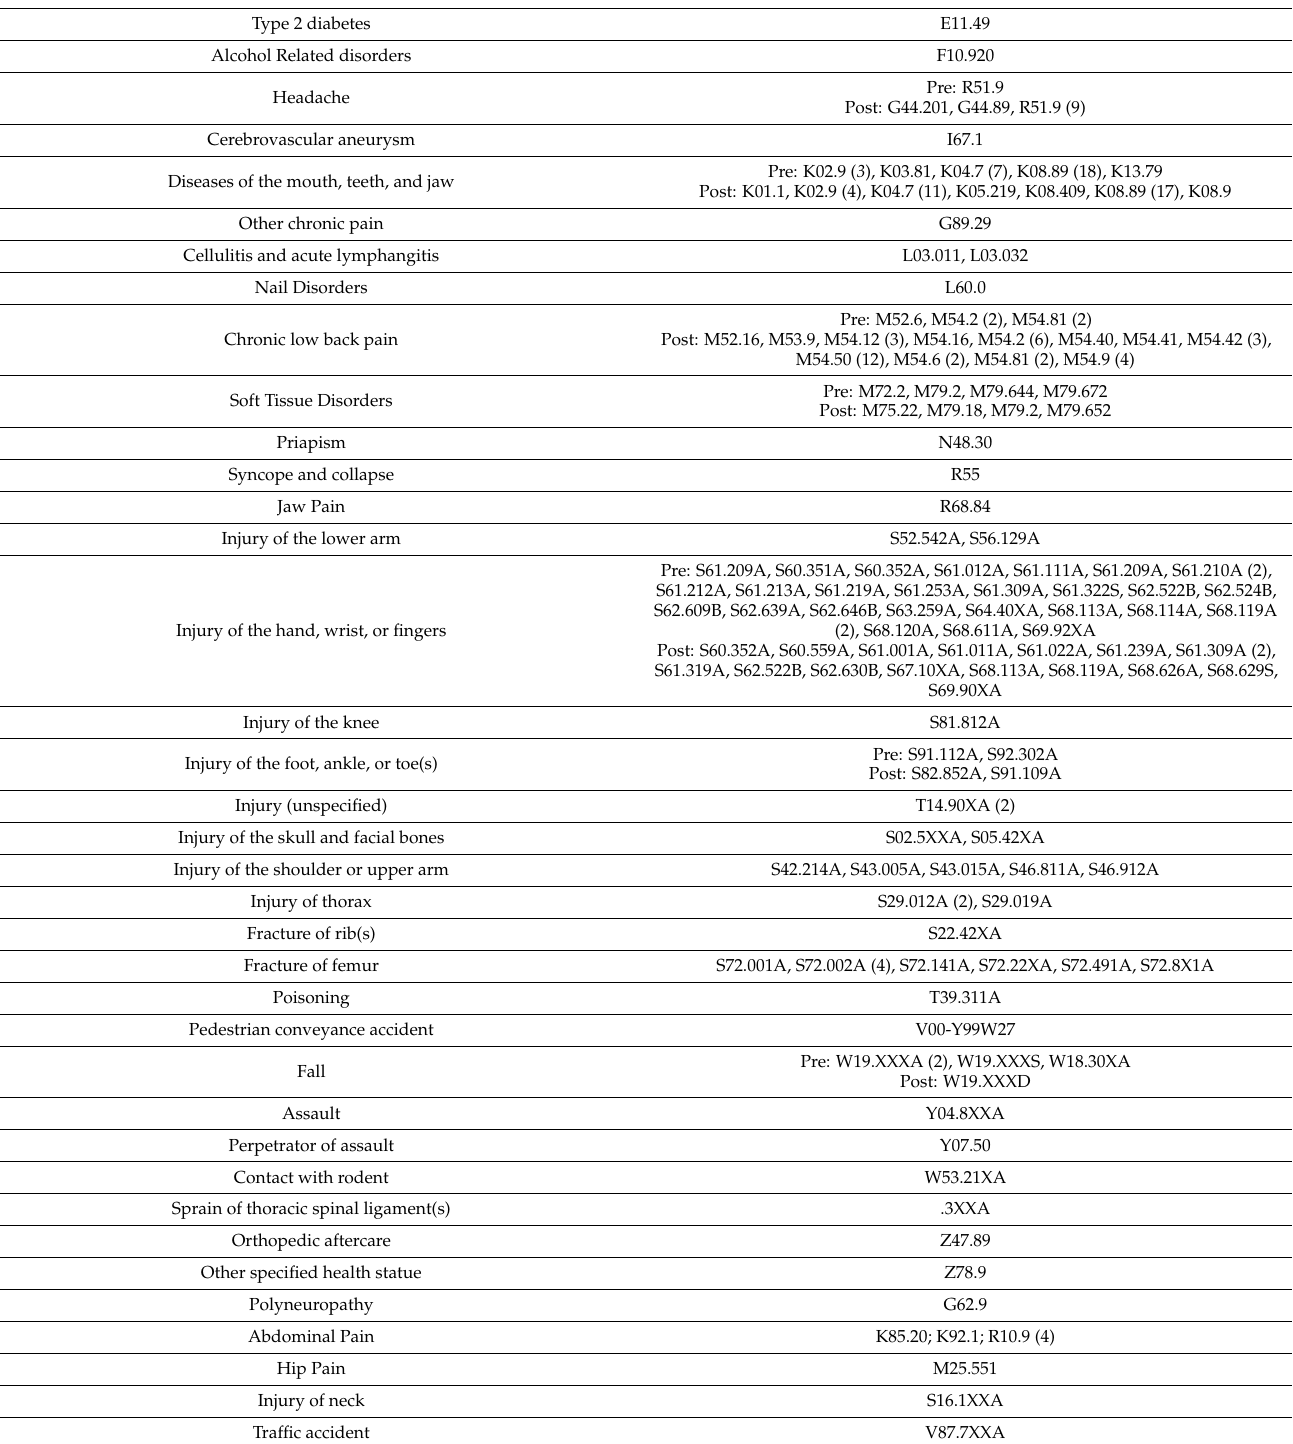
Table A2. Disease Label and Associated ICD-10